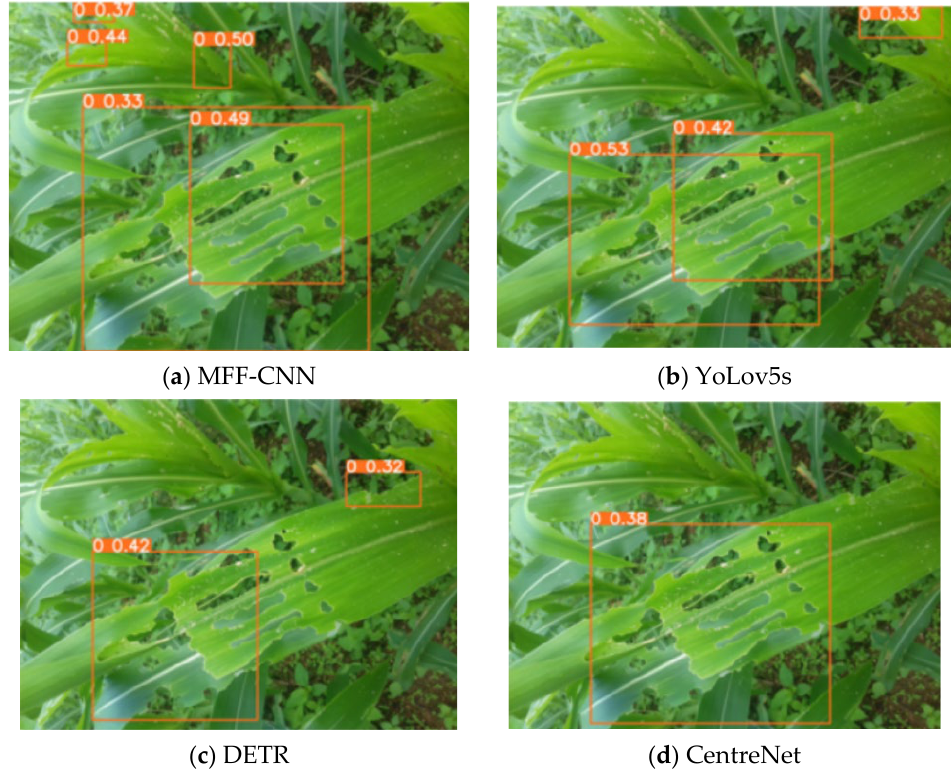
Figure 10. Detection results of the overlapping shading of diseased